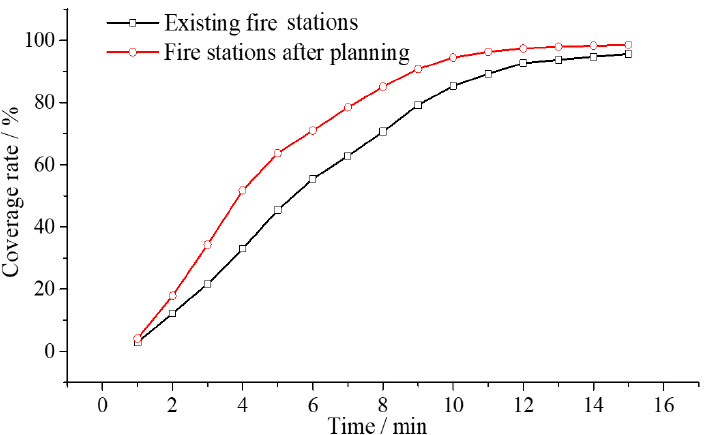
Figure 11. Area coverage rate of fire stations at different times before and after planning.